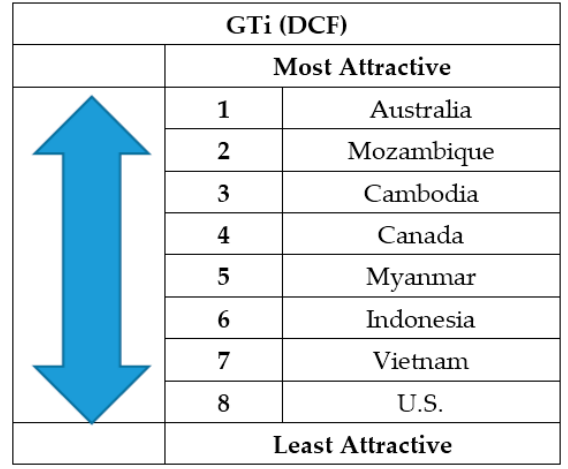
Figure 3. Attractiveness Rank of Eight Countries by GTi.